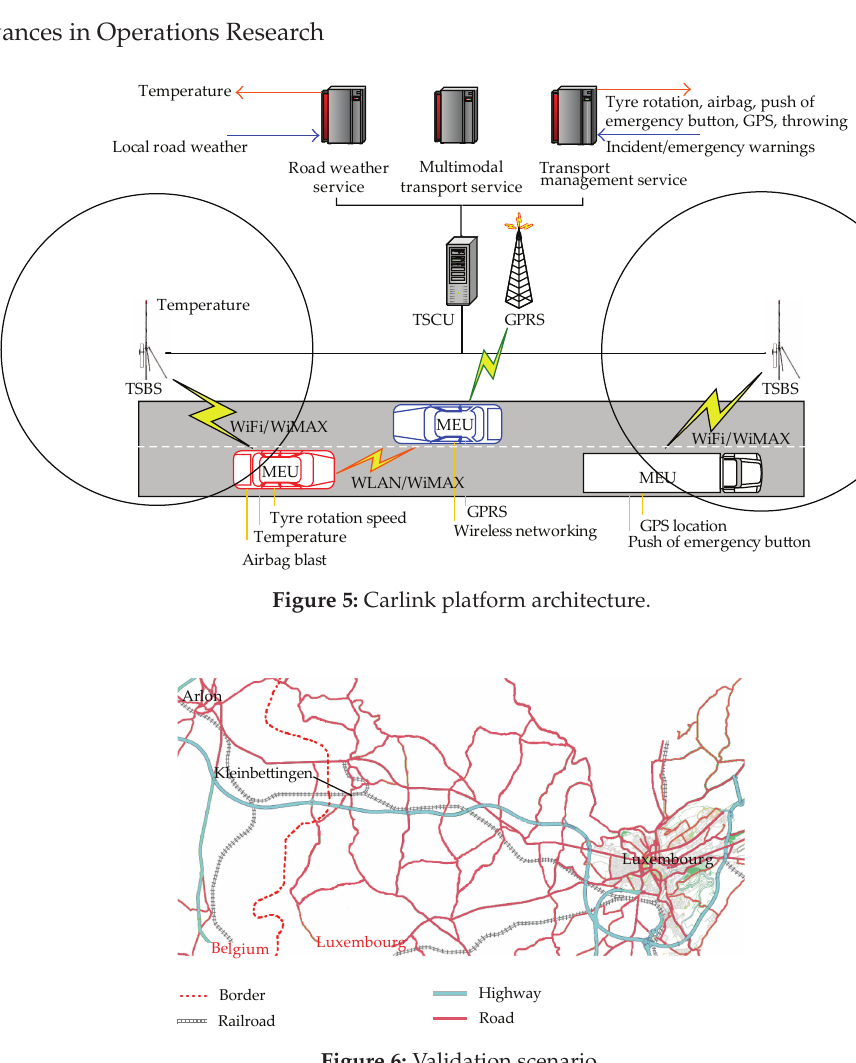
Figure 6: Validation